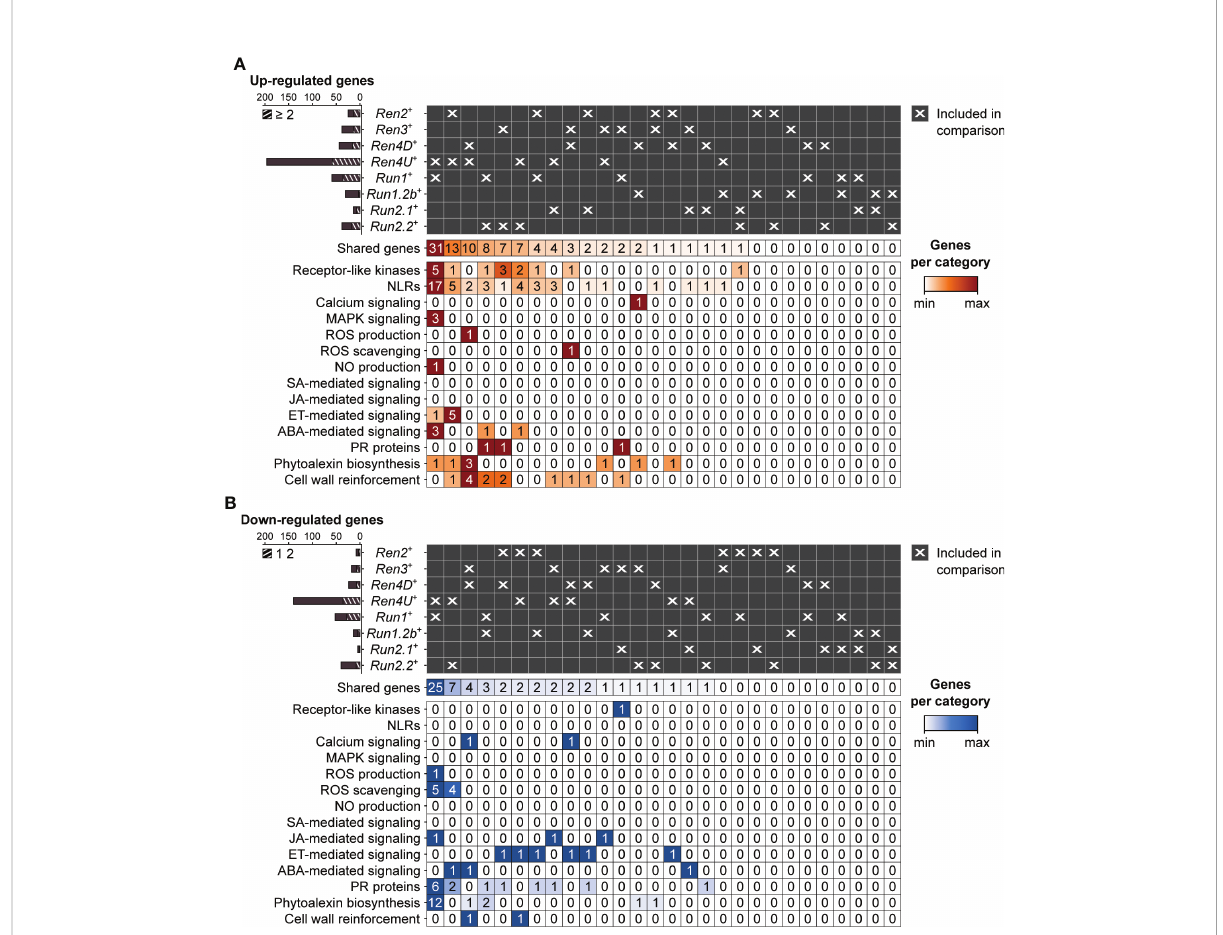
FIGURE 6 Pairwise comparison of the defense-associated genes found up- (A) and down-regulated (B) in response to E. necator at 5 dpi in only the eight accessions carrying a R locus. Striped bar plots represent the defense-related genes differentially expressed in at least two R